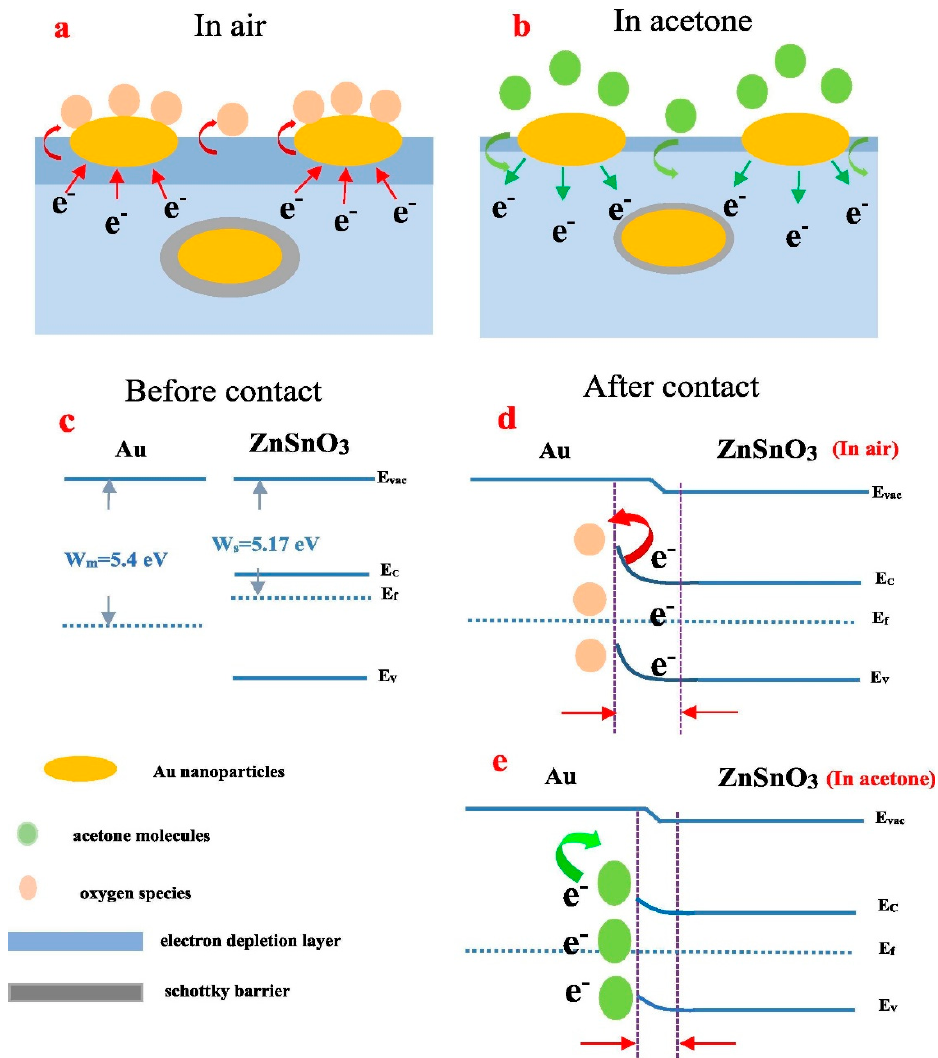
Figure 4. ( a )-( e ) Schematic illustration of the sensing mechanism of 0.25 Au/In-doped ZnSnO 3 sensor representing the Au enhanced electron generation in the presence of acetone (reproduced with the permission from reference [100]).